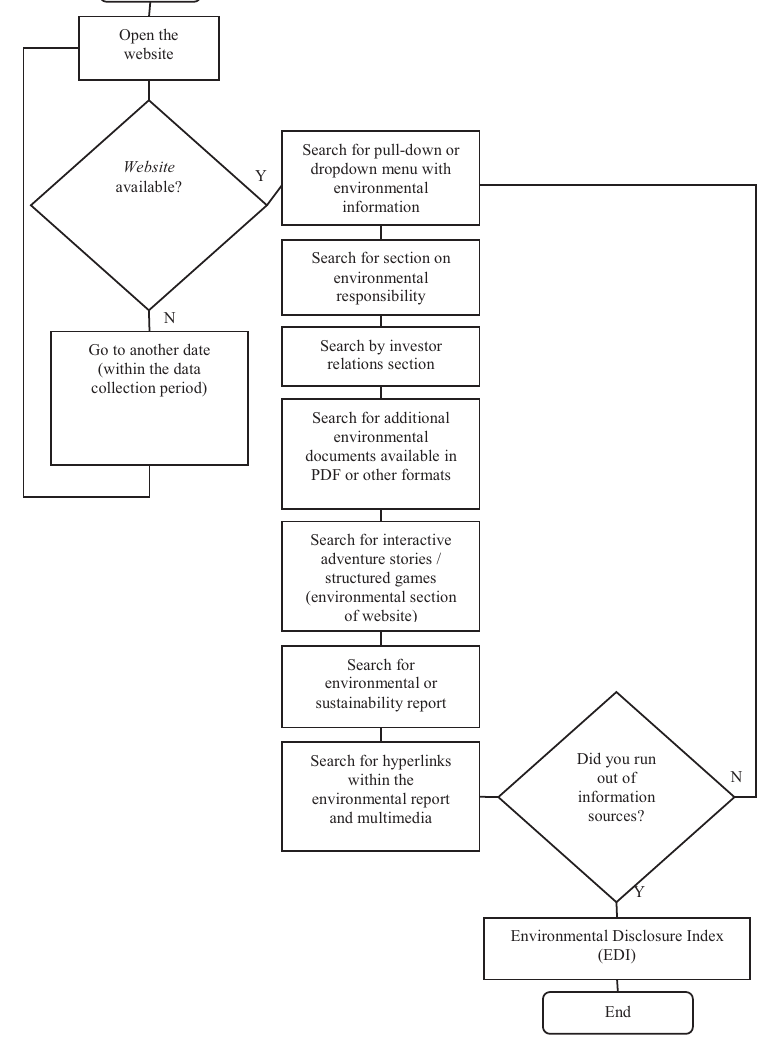
Figure 1. Diagram for